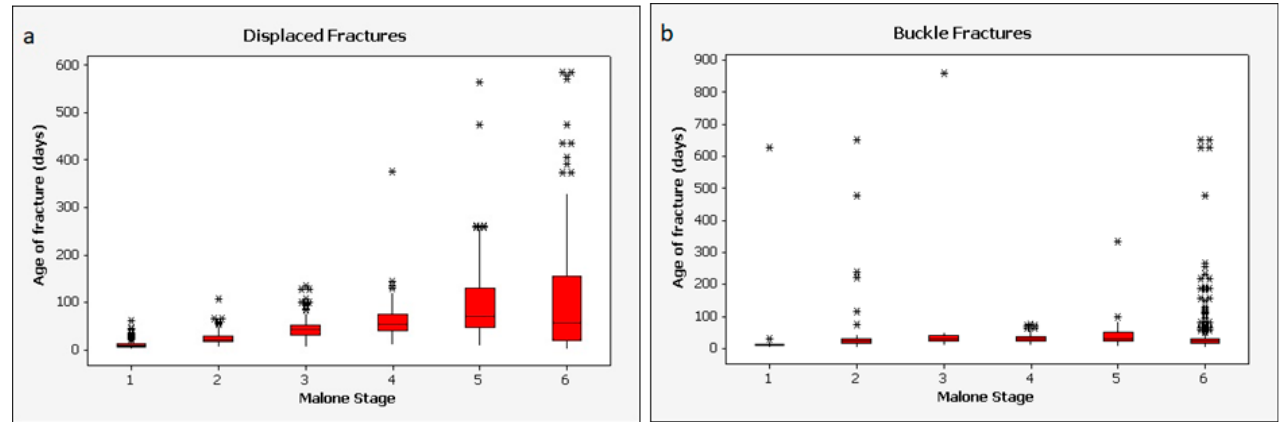
Figure 3. Descriptive plots of the fracture datasets, by Malone stage: ( a ) displaced, ( b ) buckle fractures.